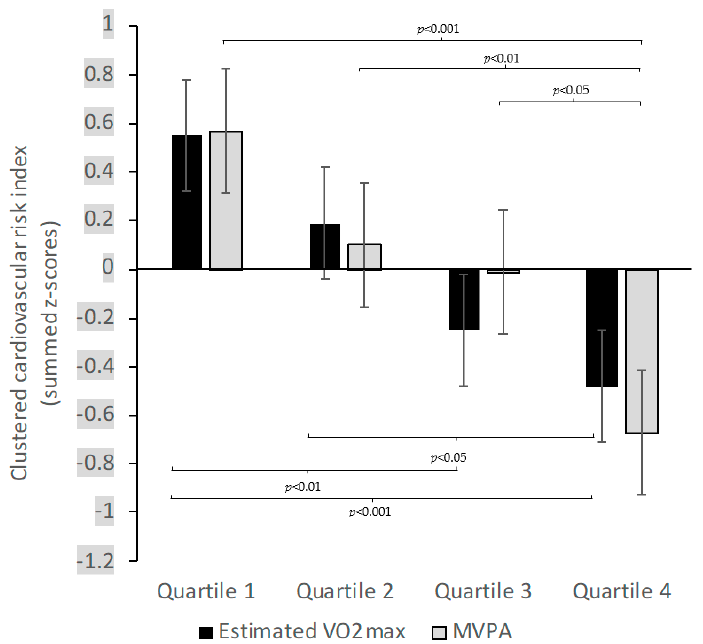
Figure 1. Means for clustered cardiovascular risk, stratified by quartiles of estimated VO 2 max and moderate-to-vigorous physical activity (MVPA) in schoolchildren from Port Elizabeth, South Africa, early 2019. Error bars represent standard error. Data are adjusted for age and sex. Table 3. Prediction of cardiovascular health risk markers with physical activity and cardiorespiratory fitness among South African schoolchildren.